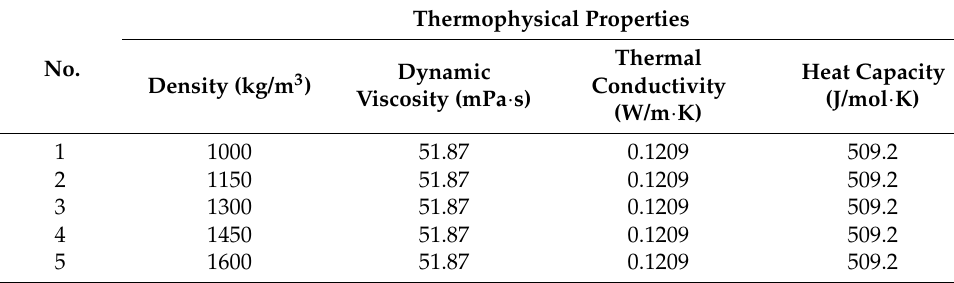
Table 2. Information on the ionic liquid properties in the hydrogen